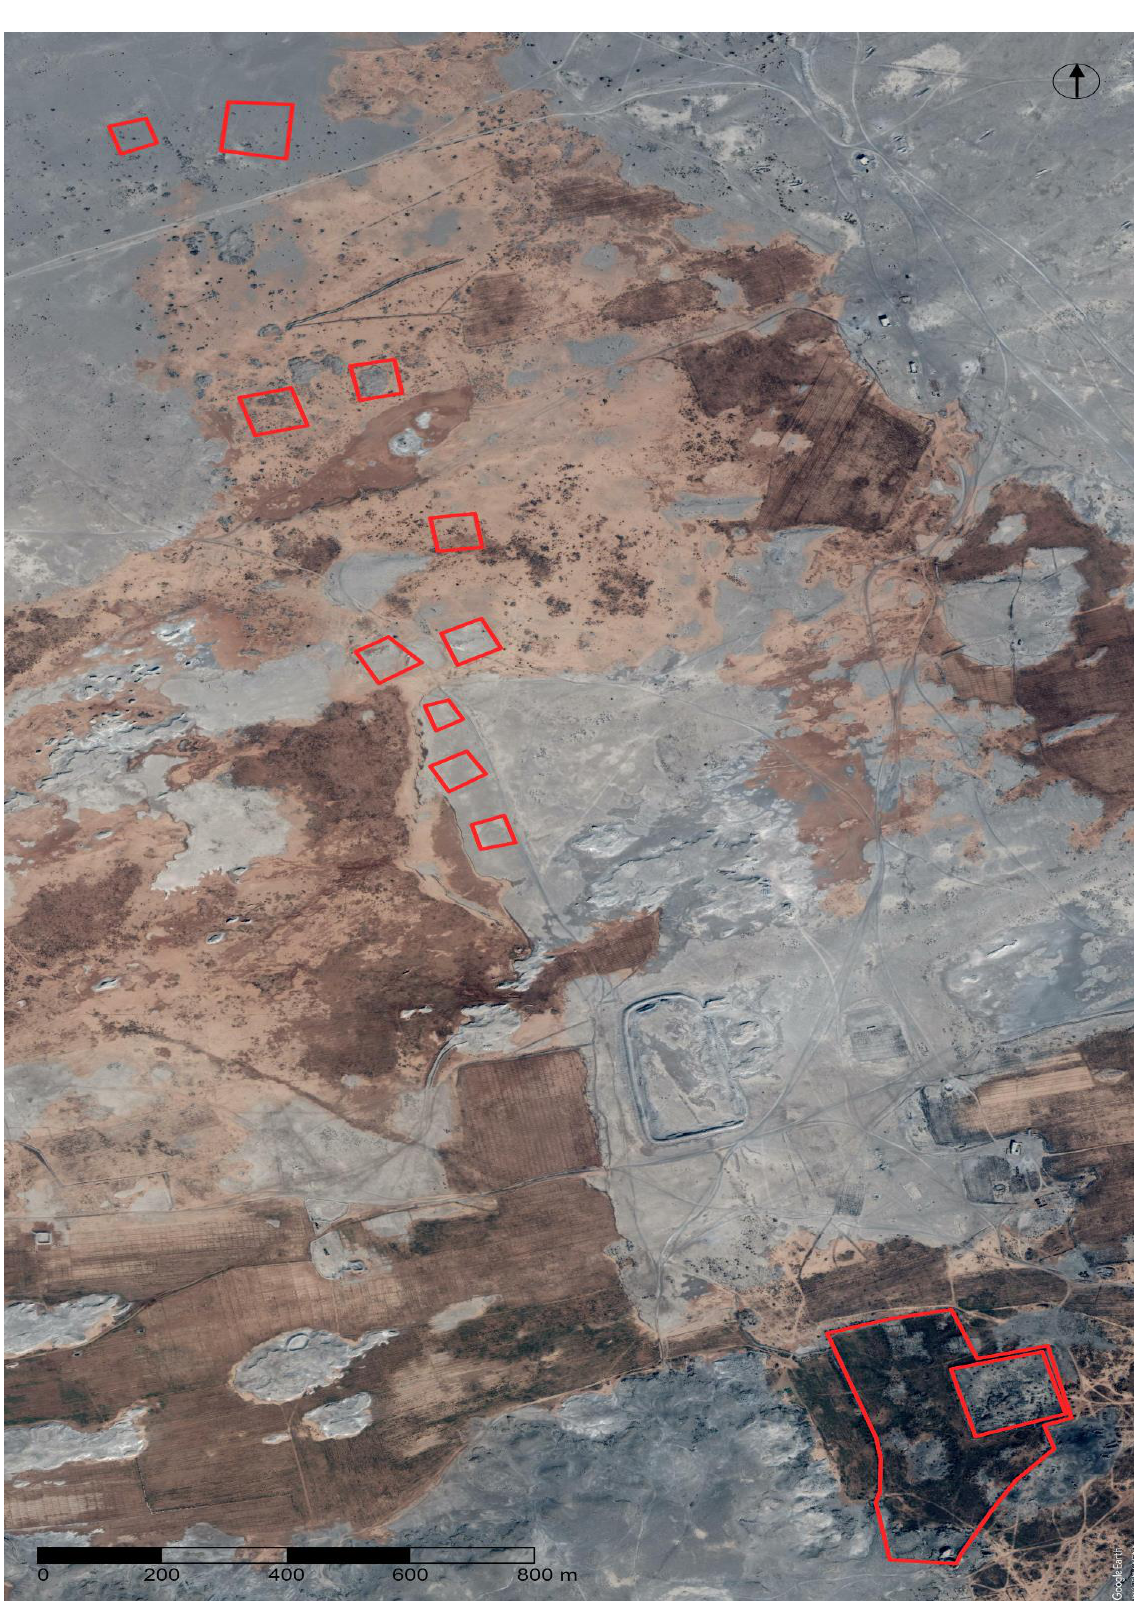
Figure 7: View with 10 of the 11 discovered auxiliary forts. View from the